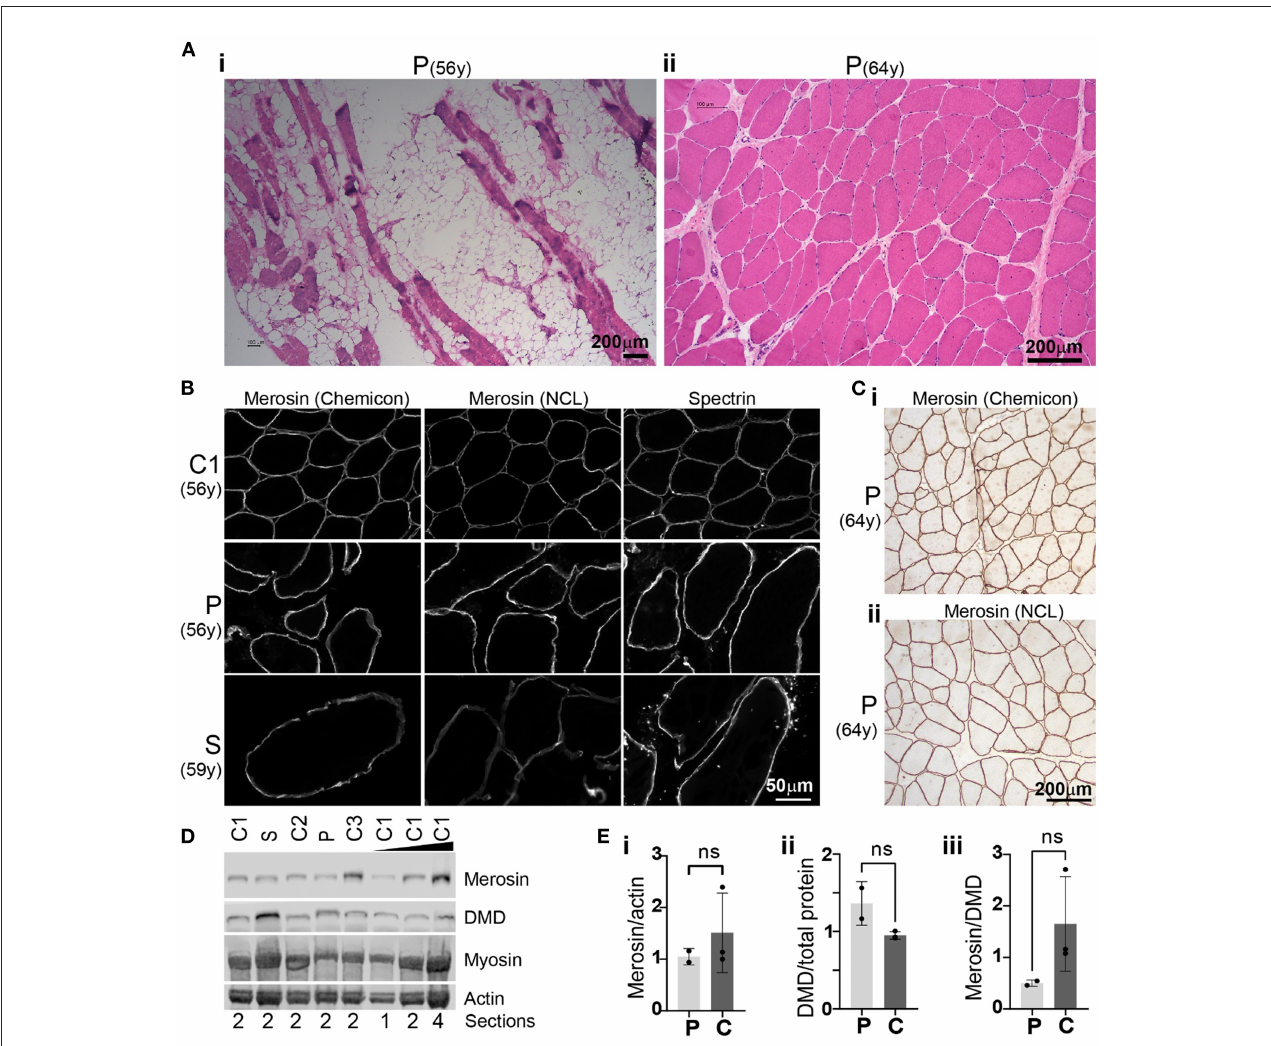
FIGURE3 Histology, immunohistochemistry and Western blot analysis. (A) Haematoxylin and eosin (H&E) staining of muscle biopsies obtained from the proband (P) at age 56 years (i; quadriceps) and 64 years (ii; biceps). Unstained areas observed in (i) represent adipose tissue infiltrates while muscle fibers appear pink in H&E-stained sections. (B) Merosin immunohistochemical staining of proband (P) quadriceps muscle biopsies and a muscle biopsy obtained from the proband’s sister (S) at 59 years demonstrating membrane-staining comparable to control 1 (C1). Immunostaining for spectrin, another membrane-associated protein, showed a staining pattern similar to merosin. (C) Immunohistochemical staining of proband biceps muscle obtained at age 64 years with two merosin antibodies (i: Chemicon MAb1922; ii: NCL-merosin Novocastra) demonstrated membrane-associated staining pattern of merosin similar to (B) . (D) Western blot of muscle from the proband (P; 56y) and his sister (S; 59y) showed merosin protein levels similar to those detected in three control samples: C1 = 56y (female), C2 = 57y (female), C3 = 59y (male). (E) Bar graphs of merosin protein levels normalized to actin (measured from total protein stain) (i), dystrophin protein levels normalized to total protein (ii) and merosin protein levels normalized to dystrophin (iii). Average ± standard deviation for proband and sister (collectively denoted as P) and controls (C) are shown. Groups were compared by using a t-test and found to be not significantly different (ns, i; p = 0.4848, ii; 0.0734, iii;